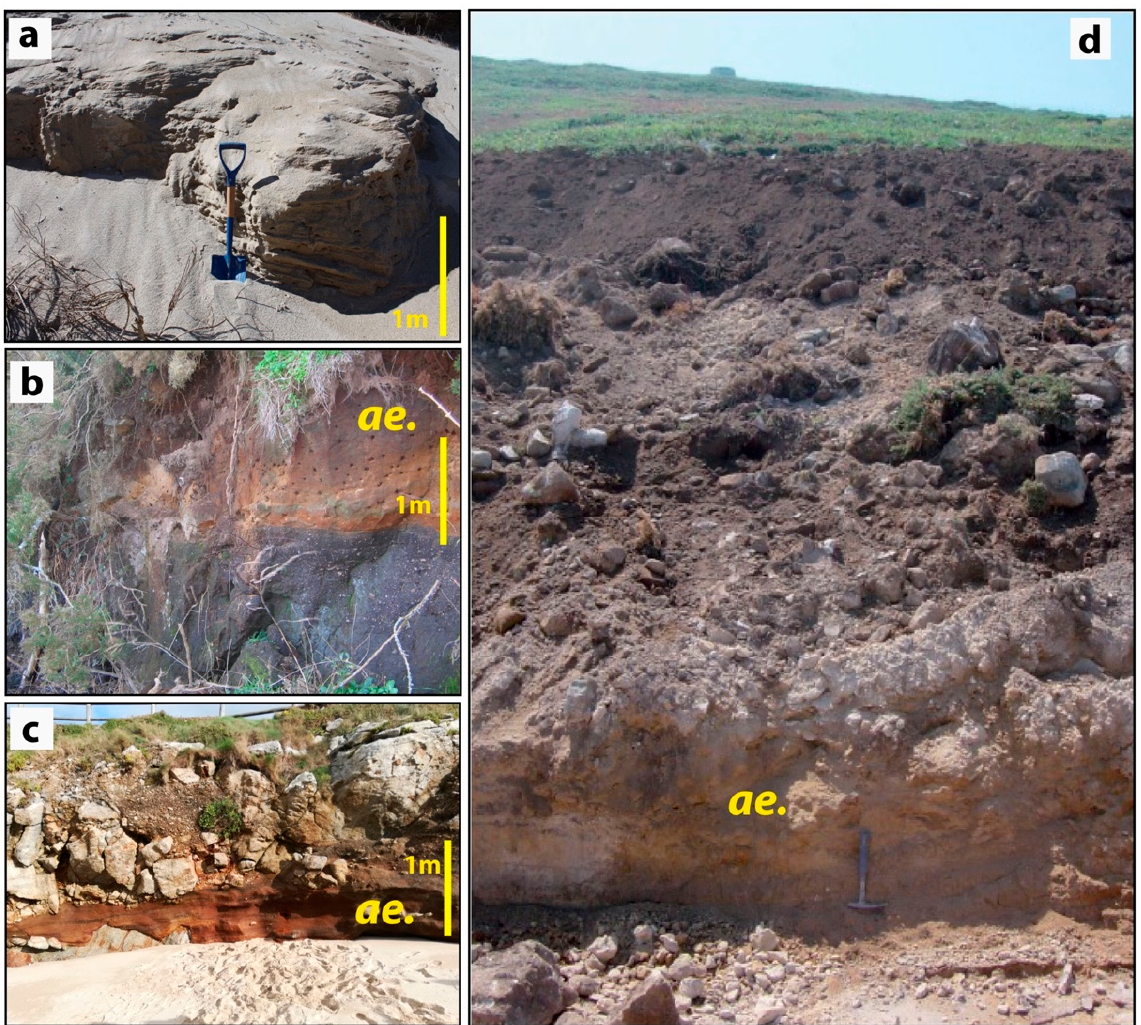
Figure 2. Some examples of fossil dunes preserved along the Galician coast and interpreted as climbing dunes [6]. ( a ) Climbing dune from Trece (43°11 ′ 15 ″ N, 9°08 ′ 45 ″ W; WGS84); ( b ) 30 ky old aeolianite from Tal (42°47 ′ 16 ″ N; 9°00 ′ 55 ″ W) [16]; ( c ) Baldaio aeolianite (43°18 ′ 11 ″ N; 8°39 ′ 24 ″ W); ( d ) Penaboa aeolianite (43°22 ′ 50 ″ N; 8°26 ′ 18 ″ W), dating back 300 ky [4]; ae: aeolian sands.